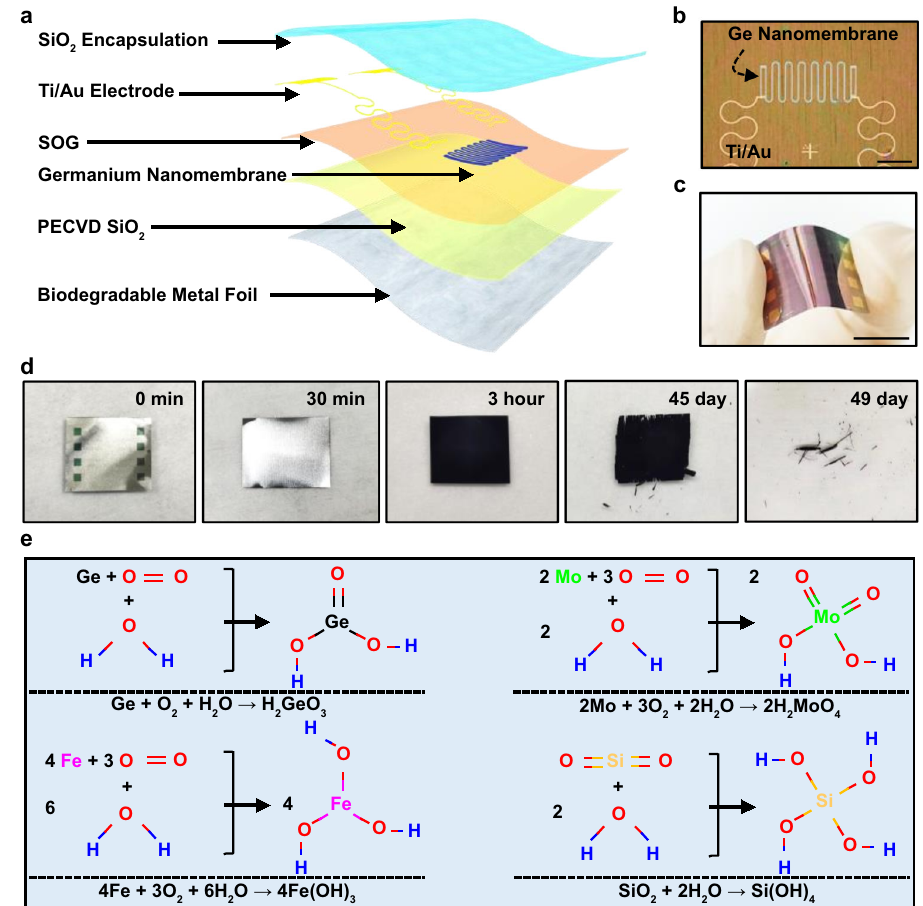
Fig. 1 Key materials and dissolution chemistries. a Exploded schematic diagram of the key components and materials of a biodegradable germanium nanomembrane-based sensor. b Optical microscope image of the sensor. Scale bar is 400 μ m. c Optical image of a 2 × 2 sensor array at the bending state, suggesting good fl exibility of the device. Scale bar is 1 cm. d Optical images of the accelerated dissolution of a biodegradable sensor in PBS (pH = 7.4, 90 °C) at different time frames. e Chemical equations of each of the constituent materials reacting with water, and all of the reactions theoretically have no gaseous resistance (TCR) also keeps as constant at different strain levels, thus providing basis for the integrated biosensing of multiple physiological signals. These presented results demonstrate the signi fi cant potential for the use of germanium in high-